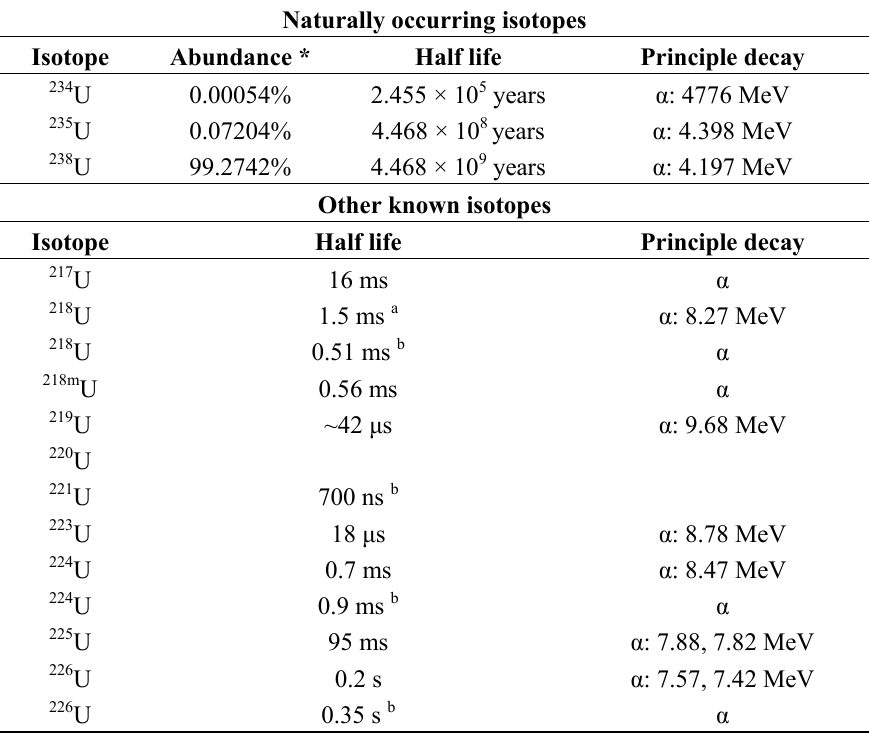
Table 1. Uranium isotopes a,b